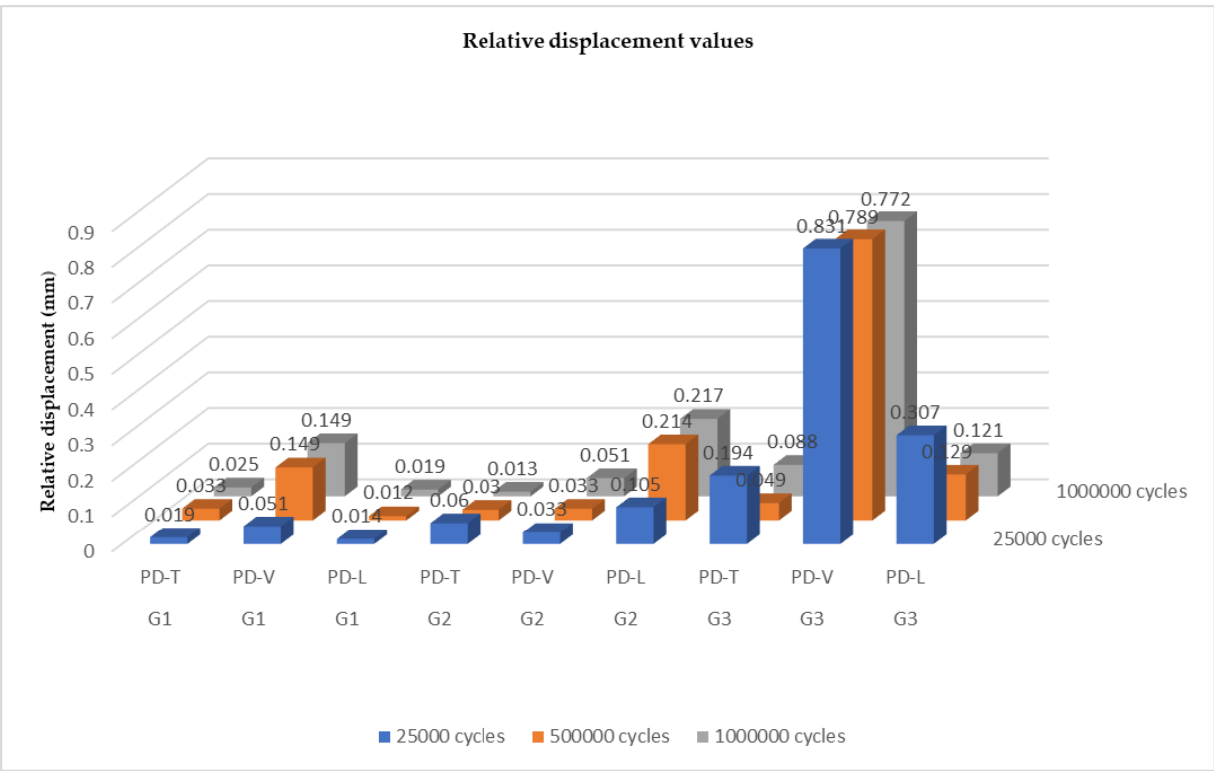
Figure 10. The graph shows the average peak displacement (PD) values in all three orthogonal directions (T—transversal, V—vertical, L—longitudinal) under cyclic low-frequency pulsed loading for the geophone locations shown in Figure 9.